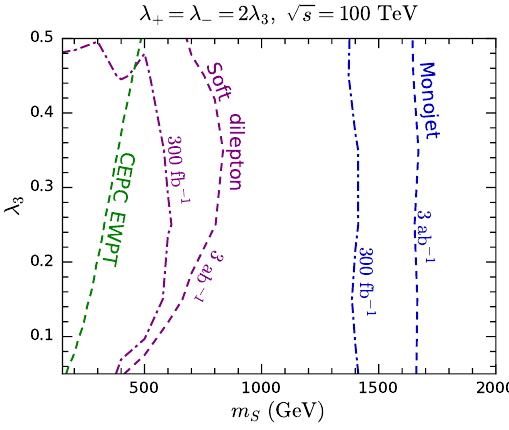
Figure 9 . Sensitivities of future pp and e + e − colliders presented in the m S - λ 3 plane for λ + = λ − = 2 λ 3 . The purple (blue) lines denote the expected 95% C.L. exclusion limits of the soft-dilepton + jets + /E (monojet + /E ) channel at a 100 TeV pp collider with integrated luminosities 300 fb − 1 T T and 3 ab − 1 . The green line indicates the expected 95% C.L. exclusion limit of the future EWPT at the CEPC [63] (see section